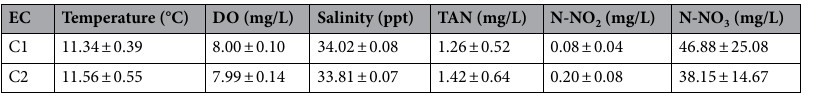
Table 1. Water quality factors for two experimental conditions (EC) in the pre-conditioning of the Pacific oyster C. gigas . C1 recirculating aquaculture system (RAS) without calcium reactor (control), C2 RAS with the calcium reactor, DO dissolved oxygen, TAN total ammonia nitrogen, N-NO 2 nitrogen nitrites, N-NO 3 nitrogen